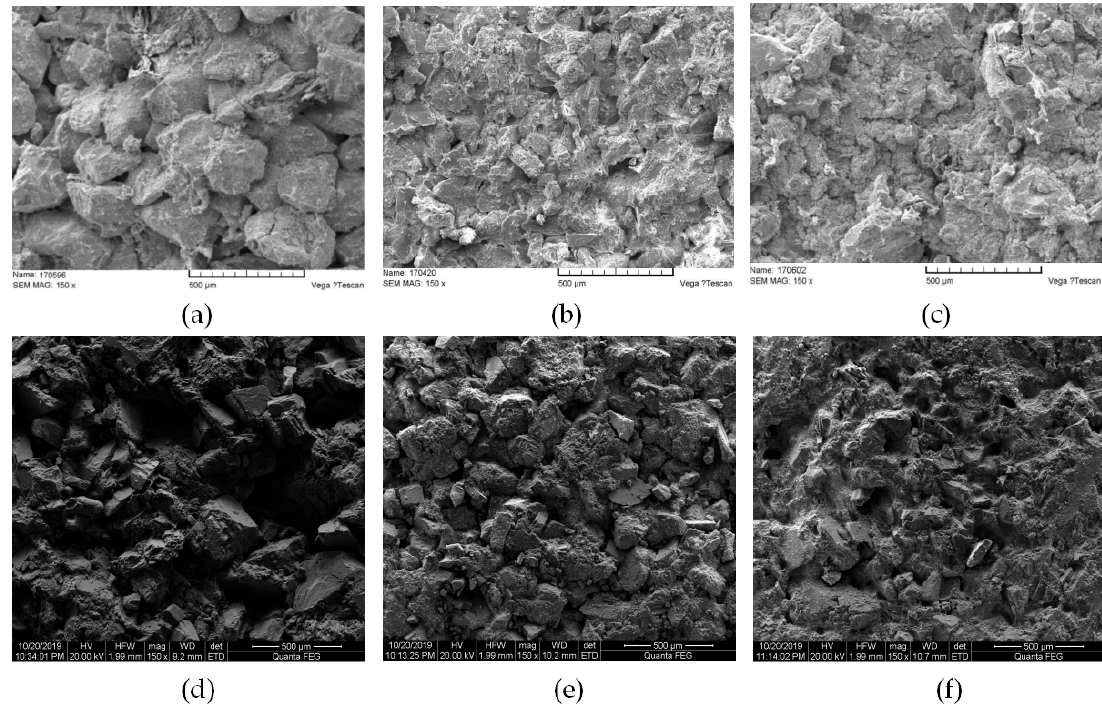
Figure 14. The scanning electron microscopy image of the targets: ( a ) 9-1, ( b ) 7-9, and ( c ) 13-5 and their synthetic sandstone counterpart ( d ) 9-1ss, ( e ) 7-9ss, and ( f ) 13-5ss.